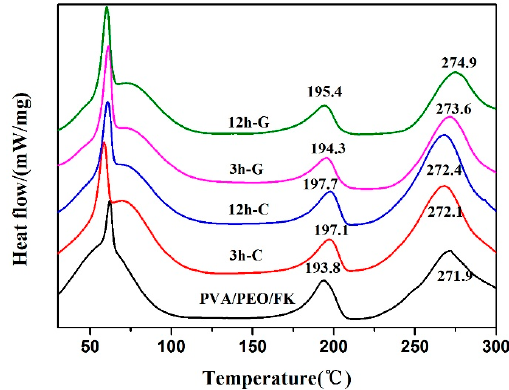
Figure 5. The DSC curves of the as-prepared and crosslinked FK/PVA/PEO nanofiber membranes.